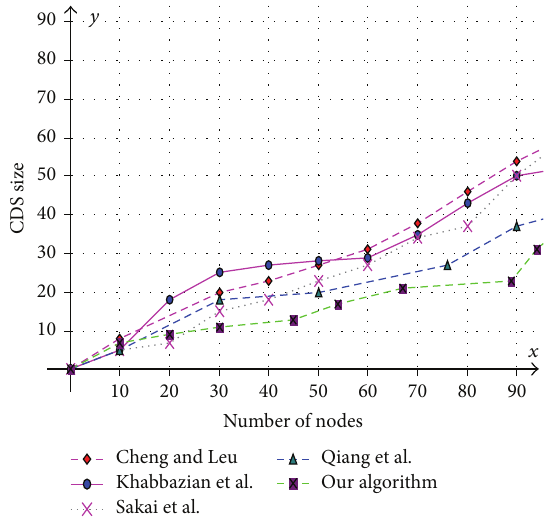
Figure 8: Number of nodes versus CDS size (transmission range = 25 mts and speed = 5 mts/s).